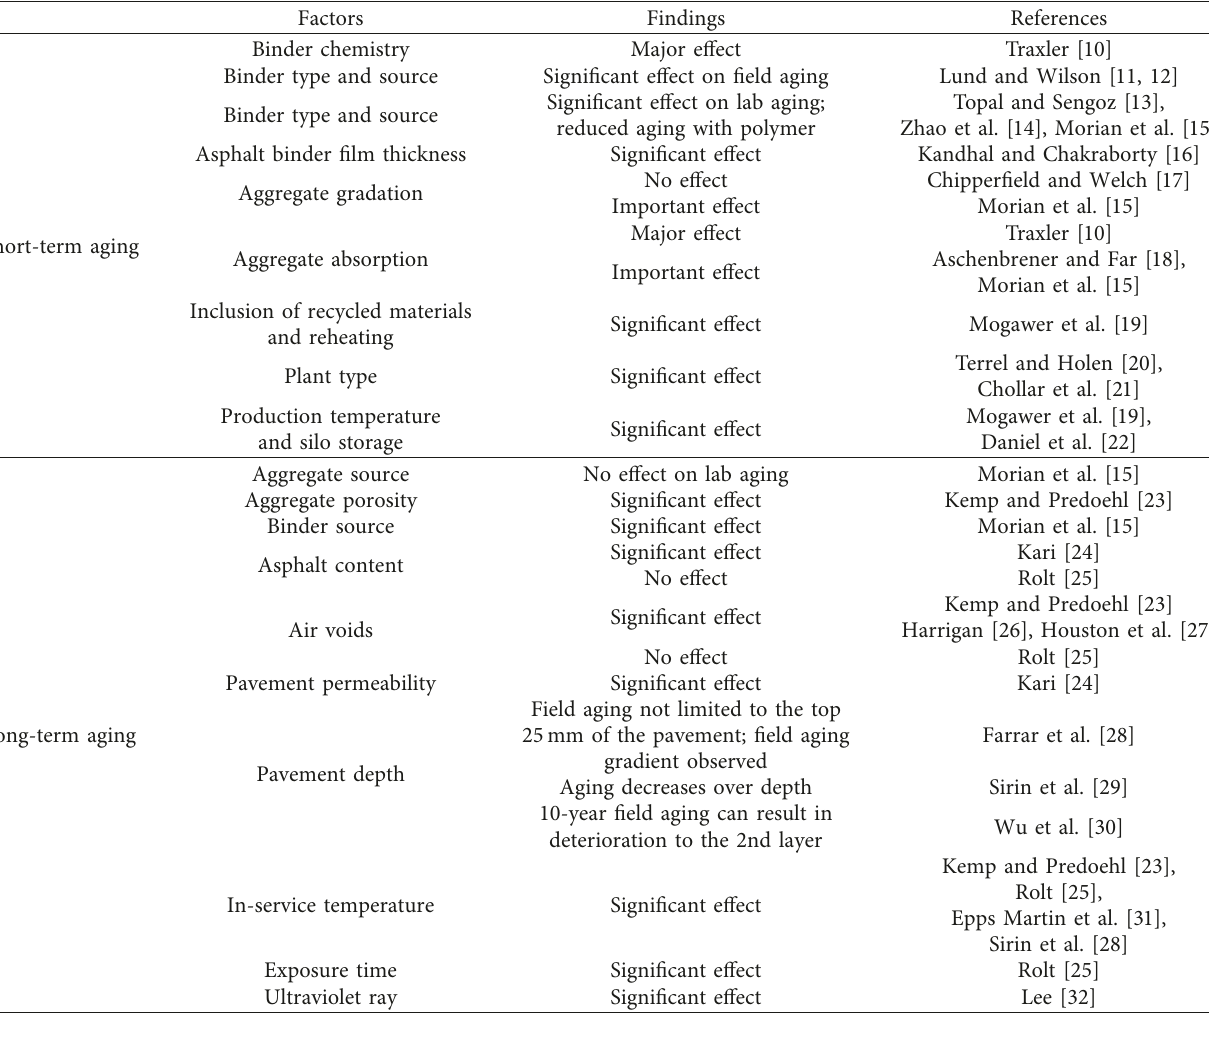
Table 1: Factors affecting aging of asphalt